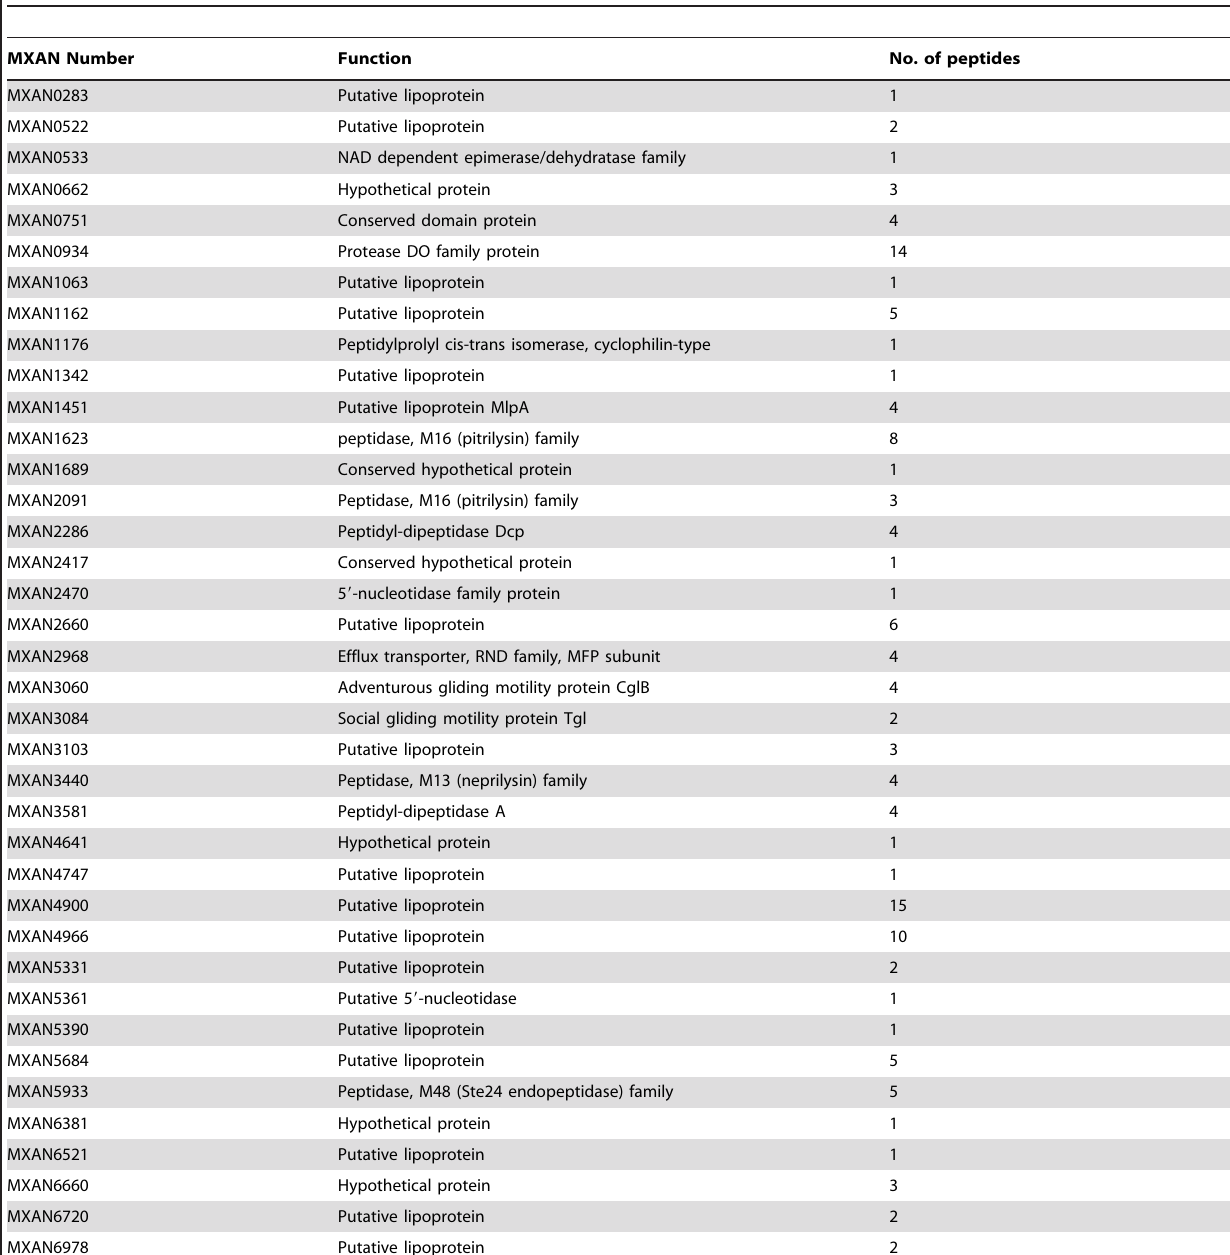
Table 4. OM lipoproteins identified by